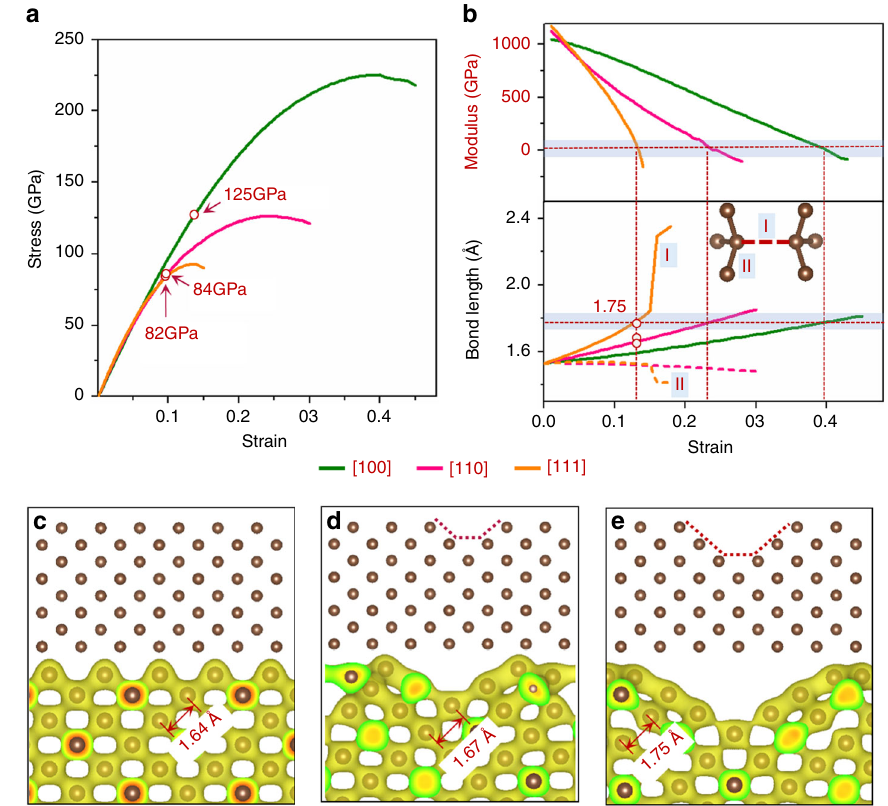
Fig. 5 First principles simulations of diamond under uniaxial tension with and without a free surface. a Theoretical stress-strain relation of uniaxial tension along [100], [110], and [111] directions for a bulk diamond. Experimentally achieved maximum tensile strains are denoted on the curves. b Young ’ s moduli and the C – C bond length as a function of uniaxial tensile strain along the [100], [110], and [111] directions. Inset b is a perspective section of the diamond crystal. For tension along [111], the bonds parallel to [111] (denoted as the type-I bond) are elongated, while others (type-II bond) are slightly contracted. For tension along [110], type-I bonds are inclined from the (110) plane while type-II bonds are in the (110) plane. For tension along [100], all bonds belong to the type-I category. The bond lengths discussed in the main text belong to type-I bond. c – e Valence charge density at 0.165 e/Bohr3 of a diamond with different surface structures under tension along [100] at strain of 13.4%: c atomically fl at surface; d free surface with a 1-atom step; and e free surface with a 2-atom step. The atomic con fi gurations (insets) are constructed based on Fig. 1b. The maximum bond lengths immediately prior to fracture, as denoted in the charge density plots, are plotted as three open circles in the bottom panel of b . Clearly, crystals with larger surface defects tend to break fi